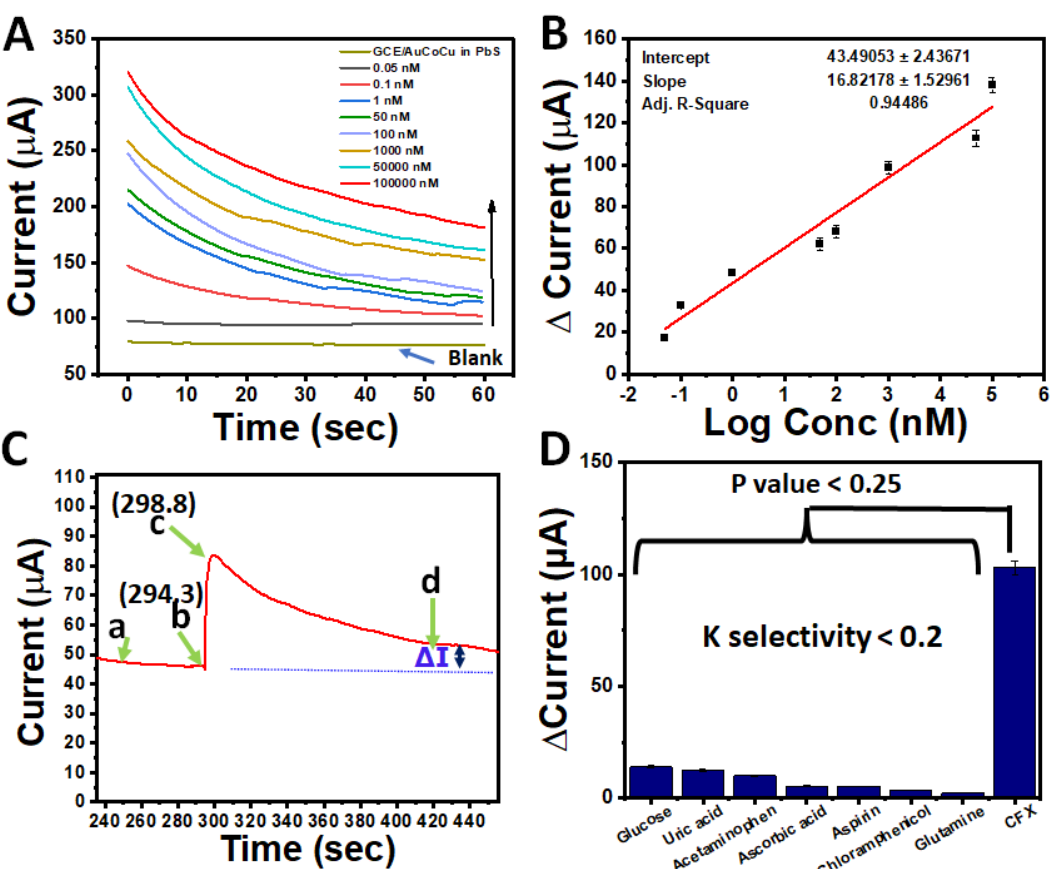
Figure 9. ( A ) Amperometric readout of GCE/AuCoCu-imprinted dendritic surface in the range of 0.05–10 5 nm CFX in PBS; ( B ) Corresponding calibration curve of CFX in PBS; ( C ) Chronoamperometric profile of the GCE/AuCoCu dendritic sensing probe showing a quick response time of 4.5 ± 0.2 s; (a) represents the stable current; after injecting the CFX at point (b), a sharp spike in current (c) due to diffusion was recorded between 294.3 and 298.8 s; following that, current saturation occurred (d). ( D ) Selectivity of GCE/AuCoCu-imprinted dendritic surface towards several co-existing molecules and CFX.